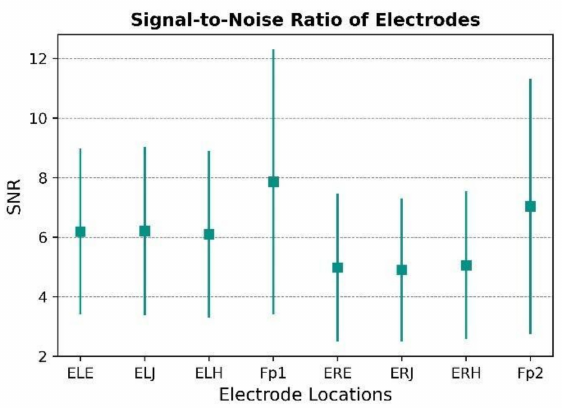
Figure 13. Signal-to-noise ratio (SNR) of electrodes on the left and right sides of the